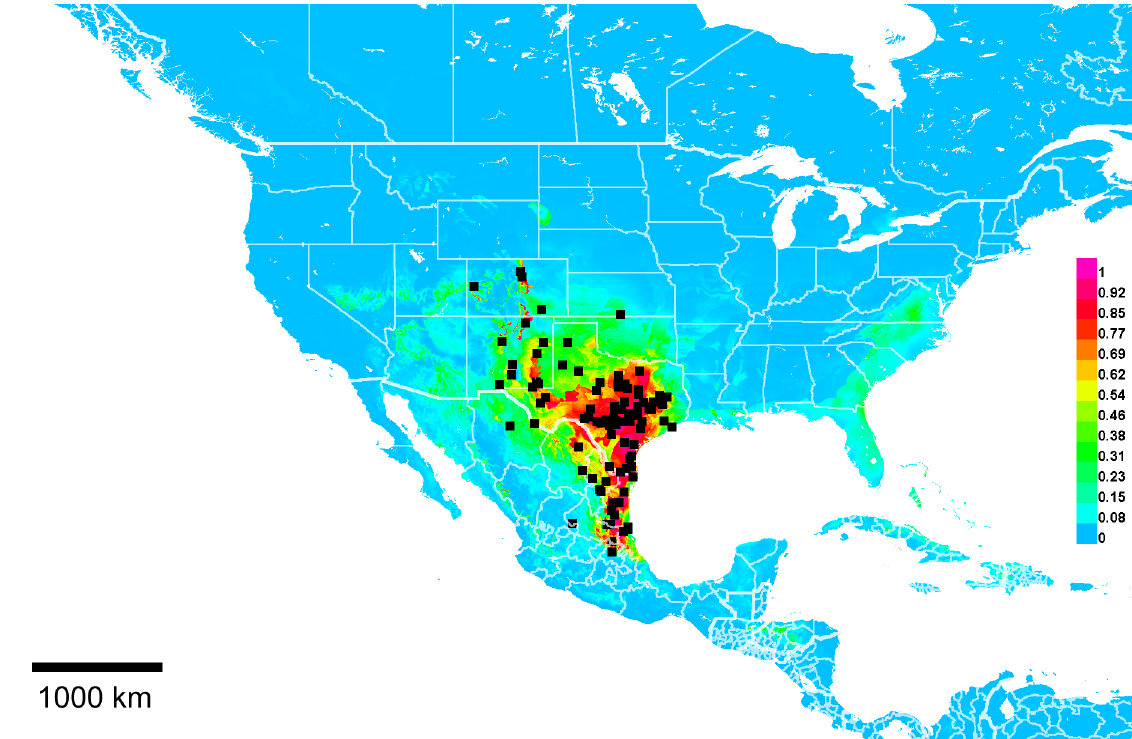
Fig. 11. Georeferenced collection records of Lasioglossum ( D .) coactus (Cresson, 1872) (black squares) and predicted distribution by maximum entropy ecological niche modelling in Maxent (colour shading). Warmer colours indicate higher cloglog probability of